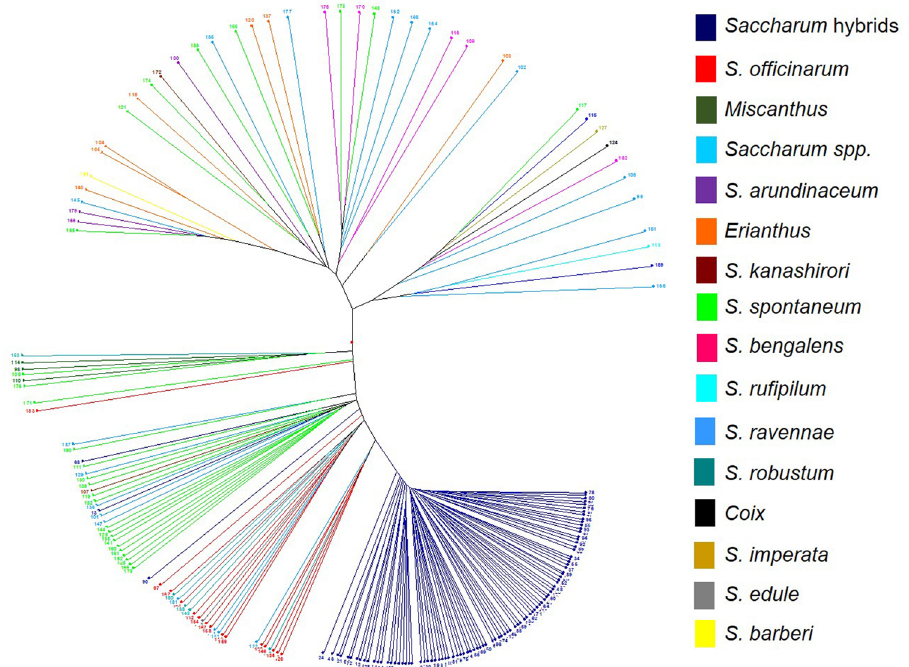
Figure 6. Dendrogram generated with an unweighted pair group method analysis (UPGMA) of the 190-clone sugarcane mini-core based on cold tolerance gene-derived SSR markers.